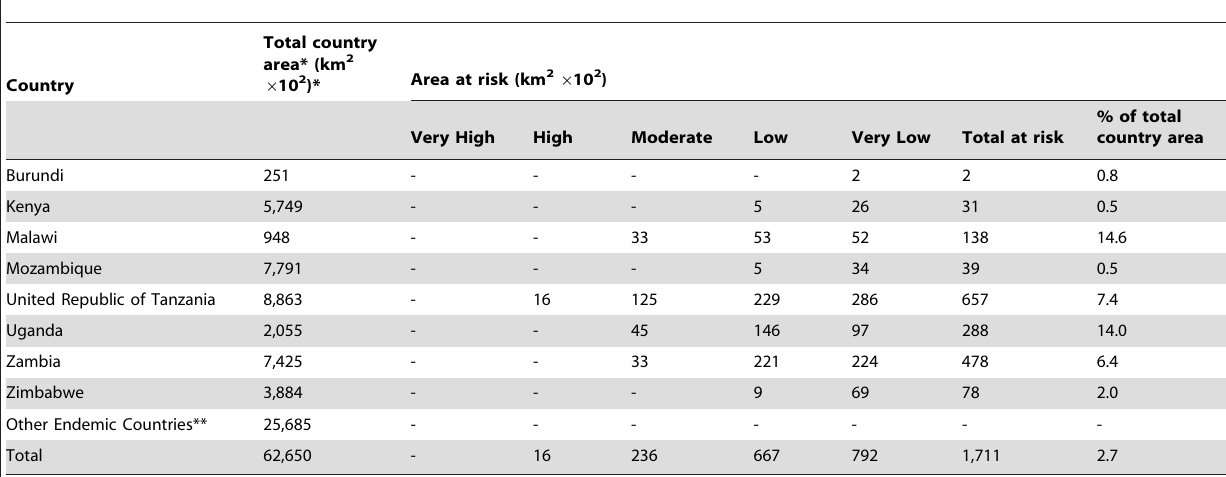
Table 3. Areas at risk of T. b. rhodesiense infection in eastern and southern Africa (km 2 6 10 2 ).